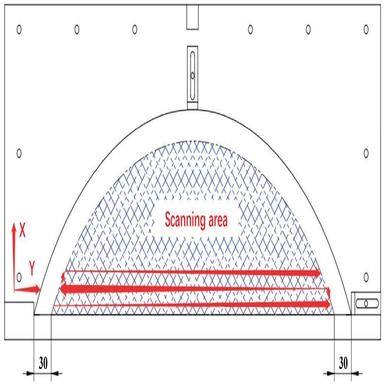
The schematic diagram of scanning strategy.